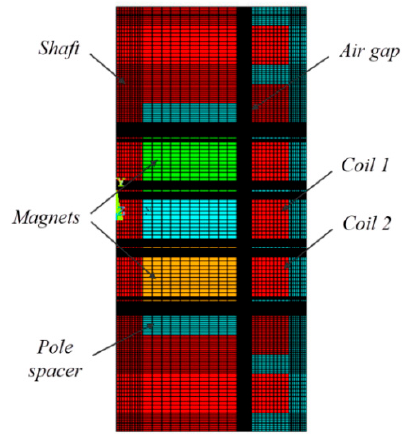
Figure 4. Finite element model of the energy-harvesting part. Table 1. Optimal parameters of the energy-harvesting part.